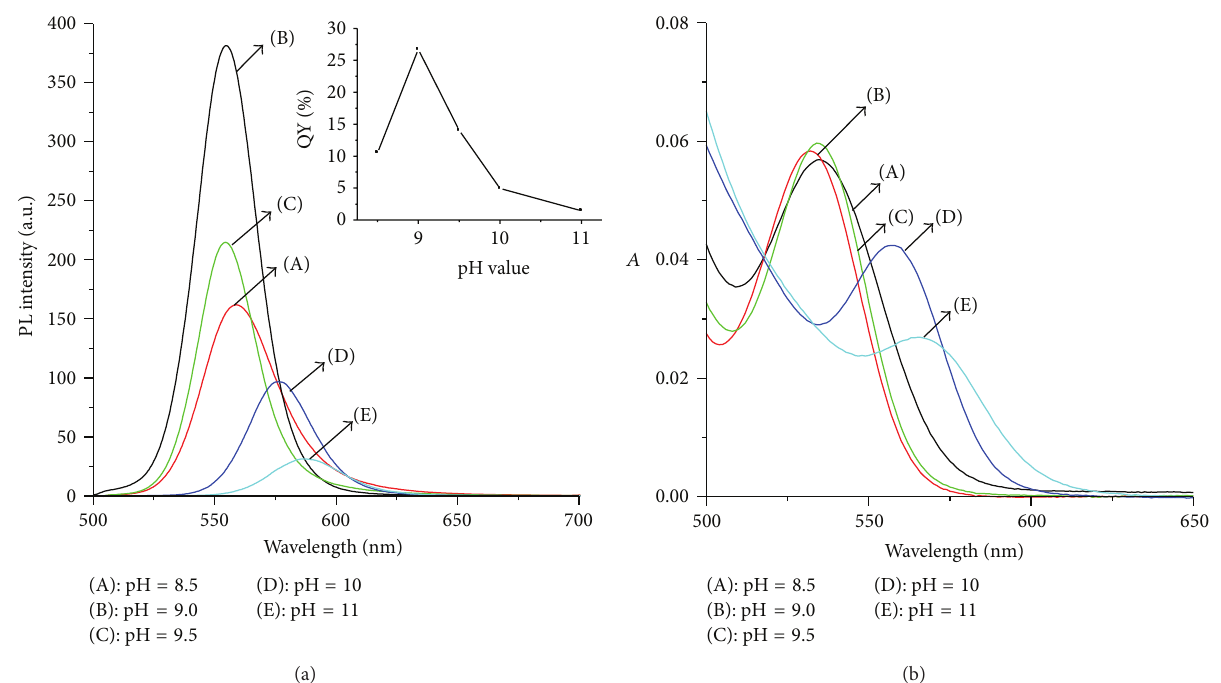
Figure 3: (a) Corrected PL spectra and (b) UV-visible absorption spectra of NAC-capped CdSe QDs grown at different pH values; the inset shows the QYs of these prepared QDs.